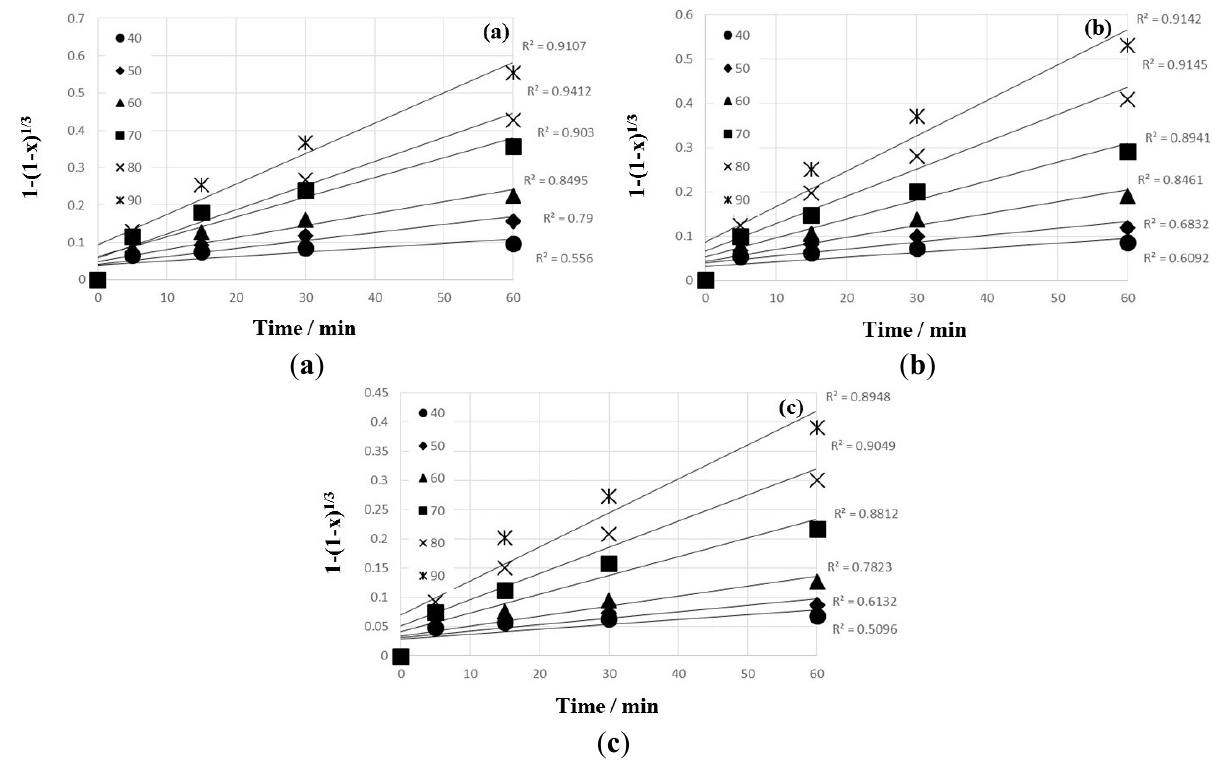
Figure 5. Plot of 1 − (1 − x ) 1/3 vs. T for different temperatures ([Fe 3+ ]: ( a ) 1.0 M;